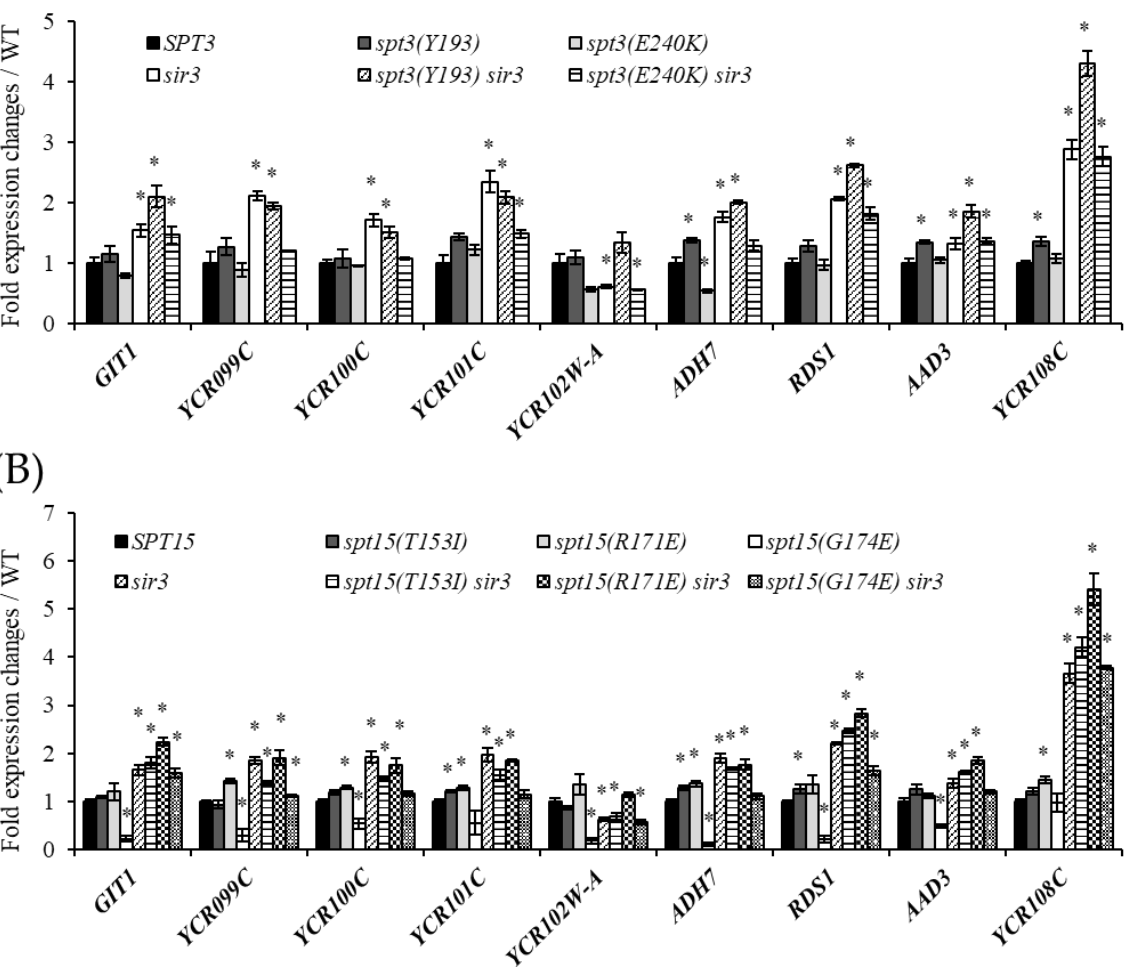
Figure 5. Interaction between Spt3 and TBP is important for boundary formation. ( A , B ) Transcription level at Chr IIIR genes in spt3 mutant strains and sir3 ∆ strains ( A ) and in spt15 mutant strains and sir3 ∆ strains by RT-qPCR ( B ). Asterisks represent p < 0.05 compared with the WT (Student’s t -test). Error bars show standard errors calculated from three independent experiments.